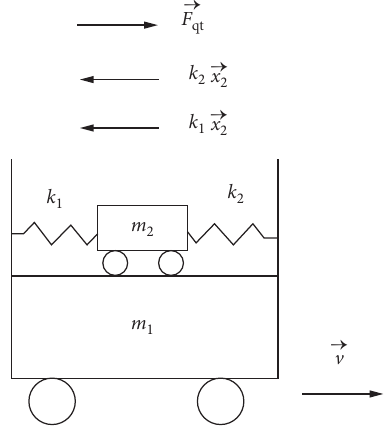
Figure 4: The forces acting on the model are estimated simply in deceleration